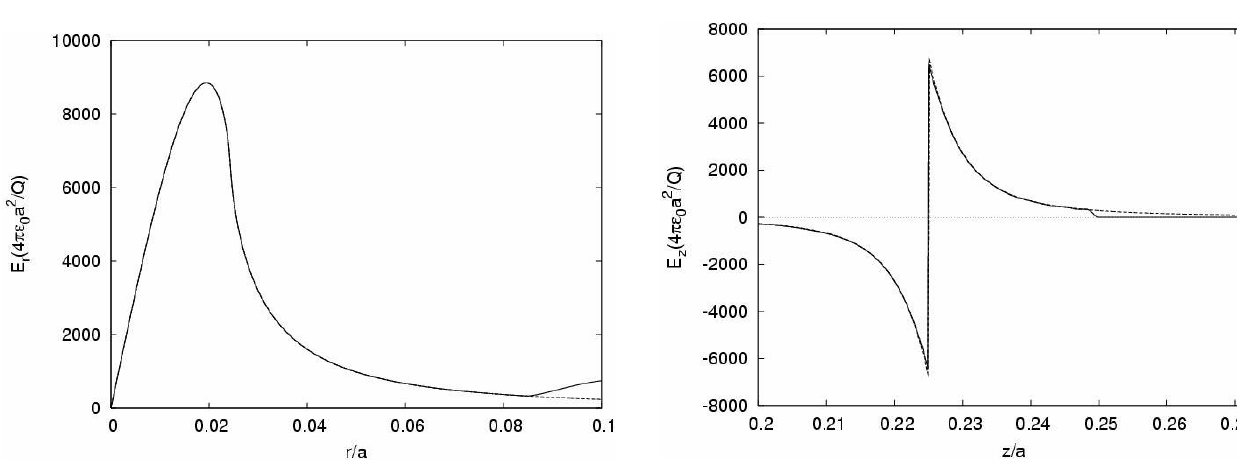
(cid:3) 4 (cid:7)" a 2 (cid:4) =Q vs r=a at the bunch location, FIG. 3. Plots of E r 0 z=a (cid:2) 0 : 225 , showing the numerical scheme (solid line) and the benchmark example (dashed